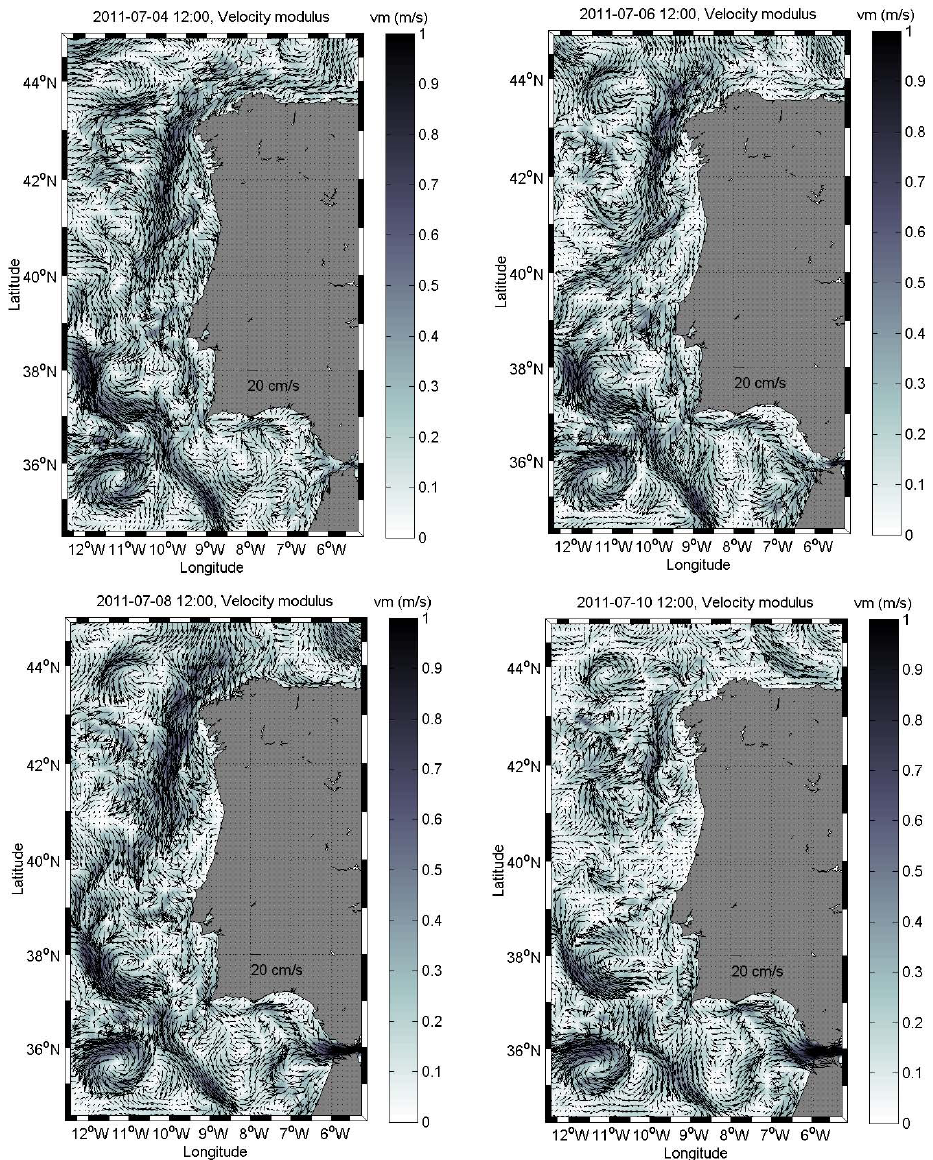
Fig. 7. Snapshots of sea surface current field predicted by the model from 4 to 10 July